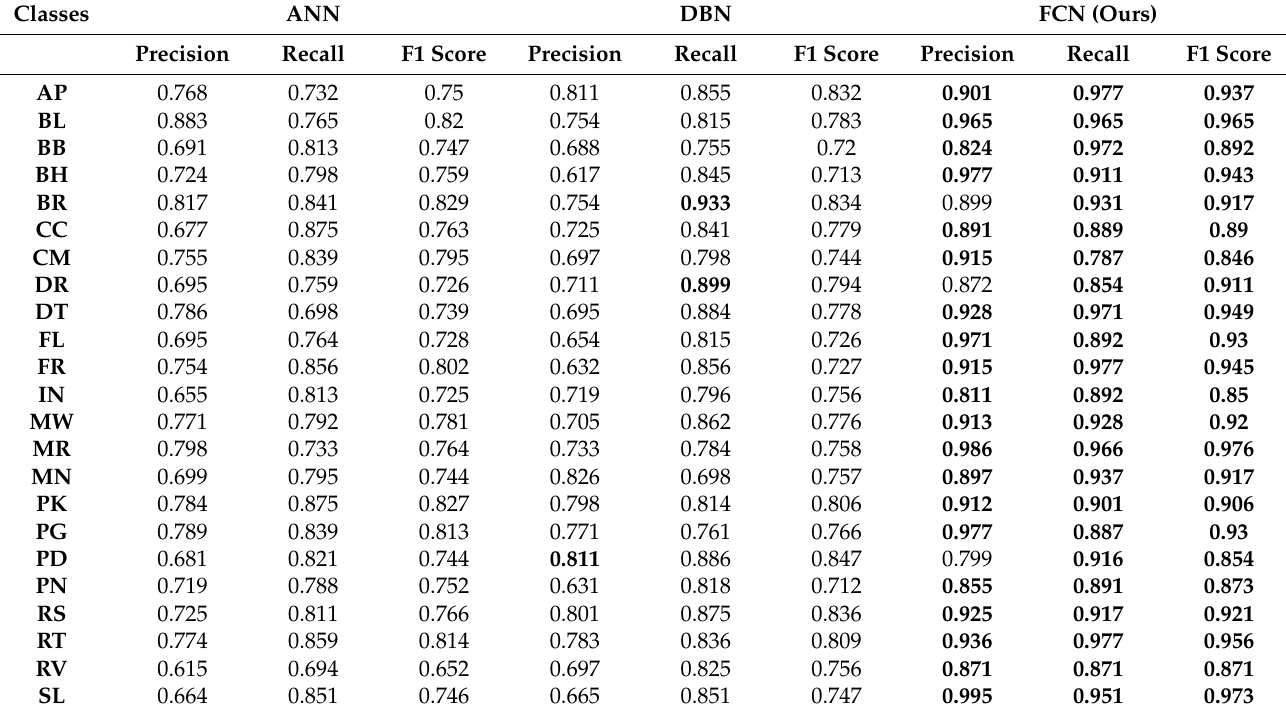
Table 2. Scene classification results against three classifiers on